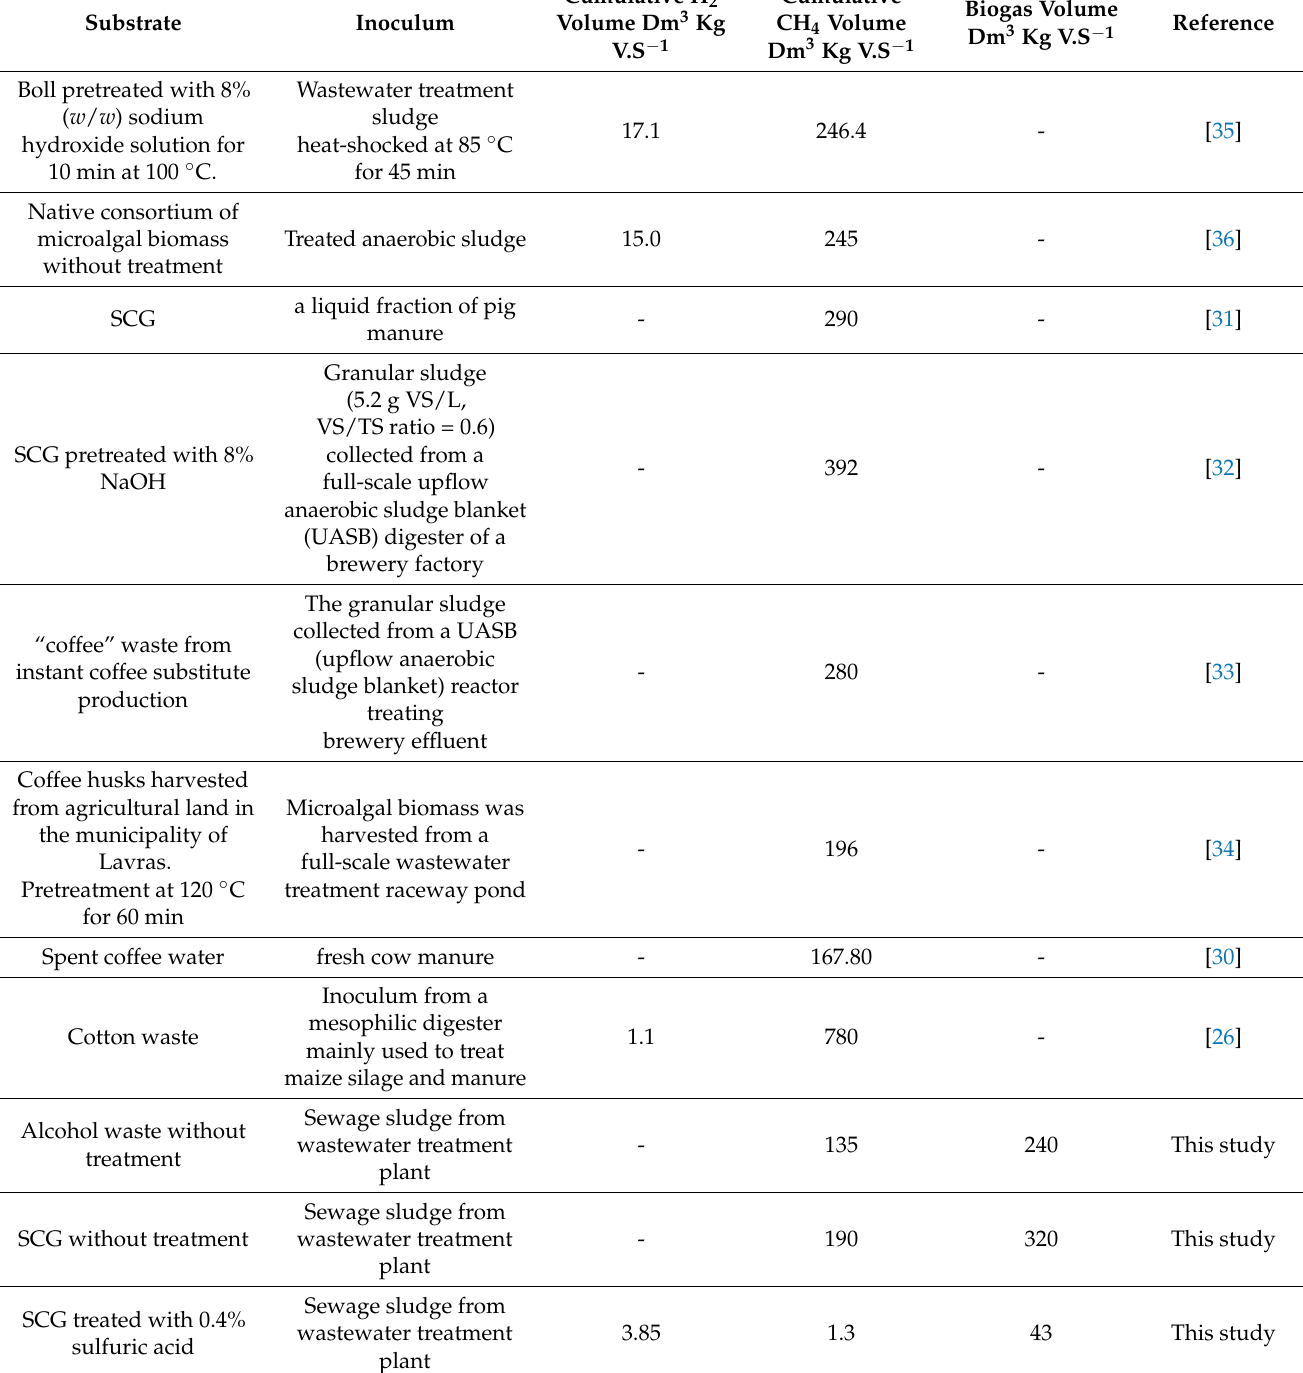
Table 2. Comparative table of methane and hydrogen